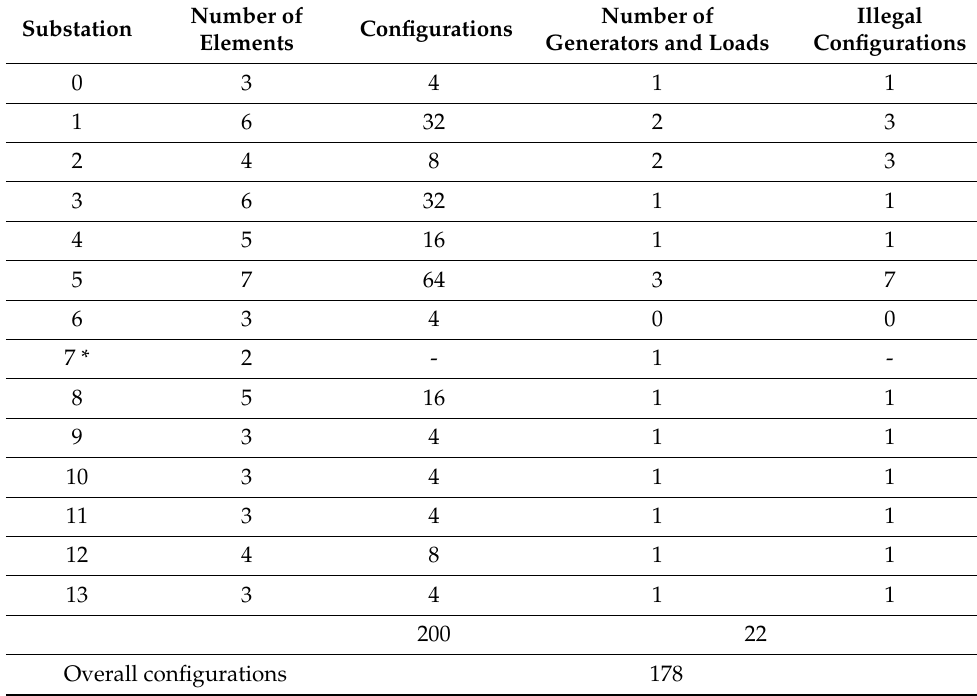
Table 2. Number of configurations for each substation.